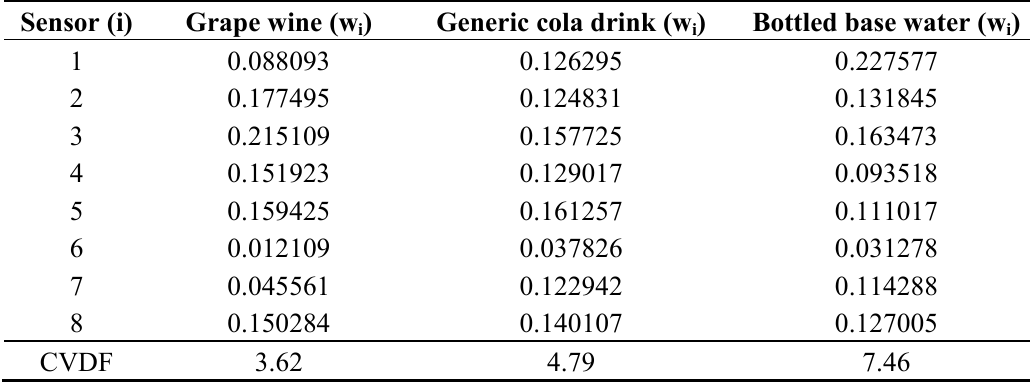
Table 5. The weighted coefficients of coefficient of variance data fusion (CVDF) for every sensor and used the pH measured data of grape wine, generic cola drink and bottled base water drinks to obtain fusion